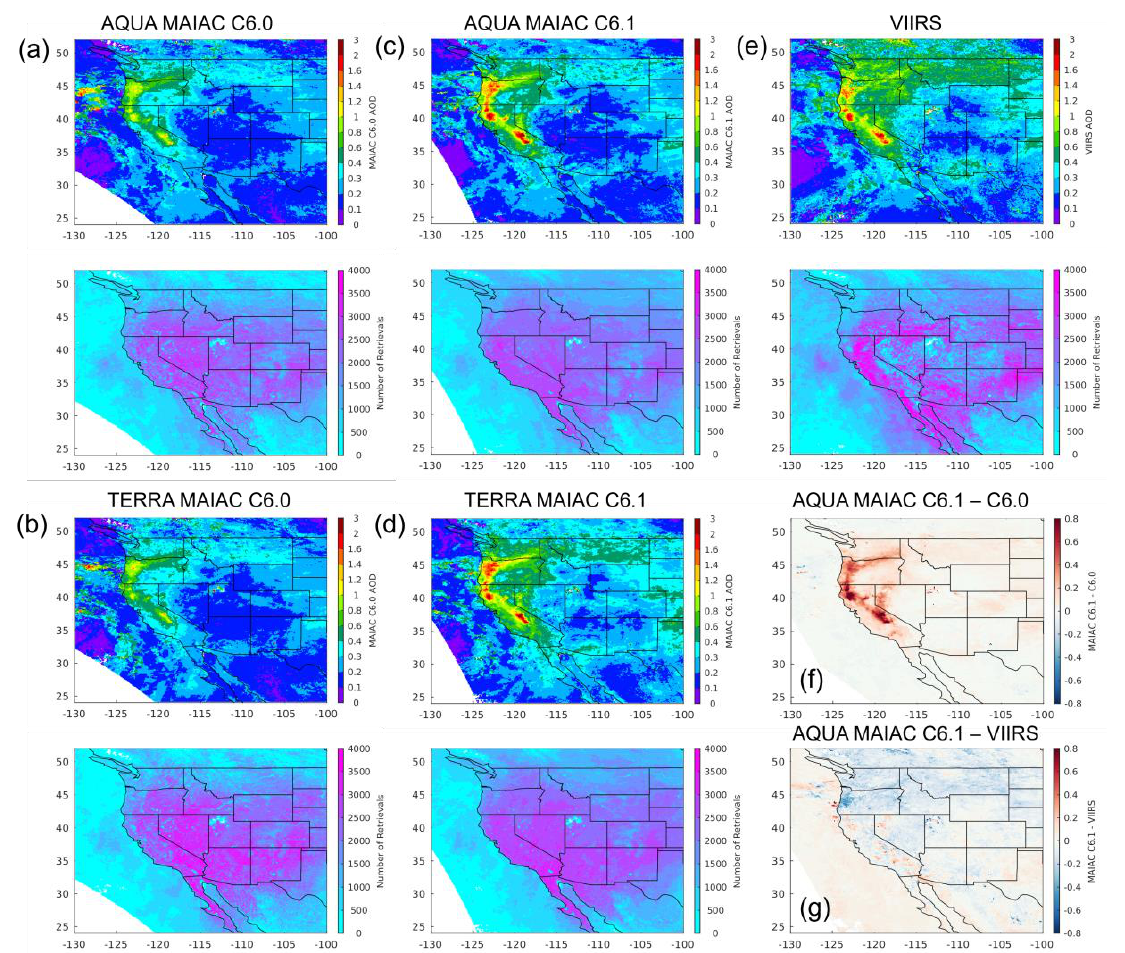
Figure 4. Maps of monthly average AOD (550 nm) and number of high-quality retrievals in the 0.1 ◦ resolution grid from Aqua and Terra MAIAC C6.0 ( a , b ), C6.1 ( c , d ), and VIIRS ( e ). The portion of missing data in MAIAC in the lower left corner of the plotting domain is due to the spatial extent of MAIAC data over North America. Panels ( f , g ) are the difference of monthly average AODs between ( f ) Aqua MAIAC C6.1 versus C6.0, and ( g ) Aqua MAIAC C6.1 versus VIIRS. The monthly AOD is averaged using daily collocated grid cells where both products have retrievals simultaneously. The domain averages of ( f , g ) are 0.027 and − 0.036,